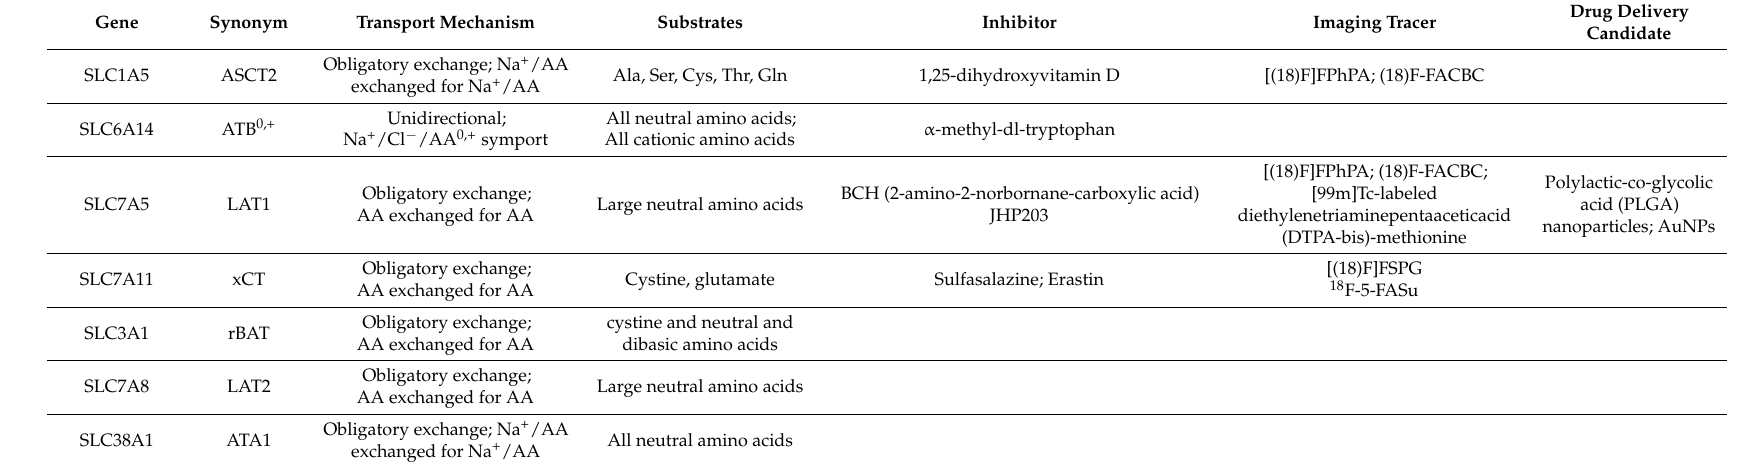
Table 1. Portfolio of amino acid transporters overexpressed in breast